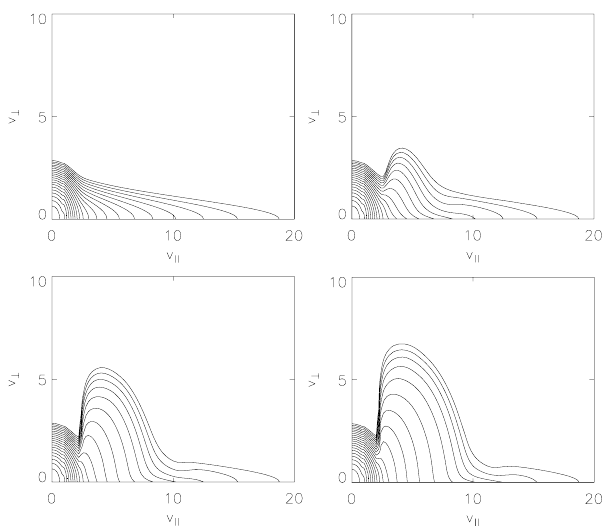
Fig. 4. Electron distribution function at times t = ( 0 ; 2 . 2 × 10 3 ; 2 . 9 × 10 3 ; 3 . 2 × 10 3 ) 1 for S2 set of parameters. Velocities ω ce are measured in v T, c